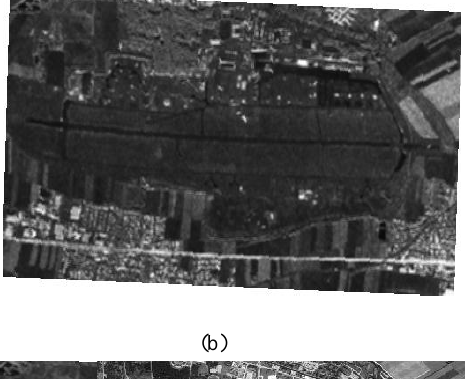
Fig.2 Registration of optical and SAR images. (a) Optical image (b) SAR image (c) The result of the proposed method. (d) The result of MIOI. (3) Fig.3 shows the optical and SAR images acquired around an overpass and the registration results. The optical image obtained from Google Earth and Cosmo image with 1m resolution are shown in Fig.3 (a) and Fig.3 (b) respectively. The registration result of the proposed method is shown in Fig.3 (c). The result of MIOI is shown in Fig.3 (d).